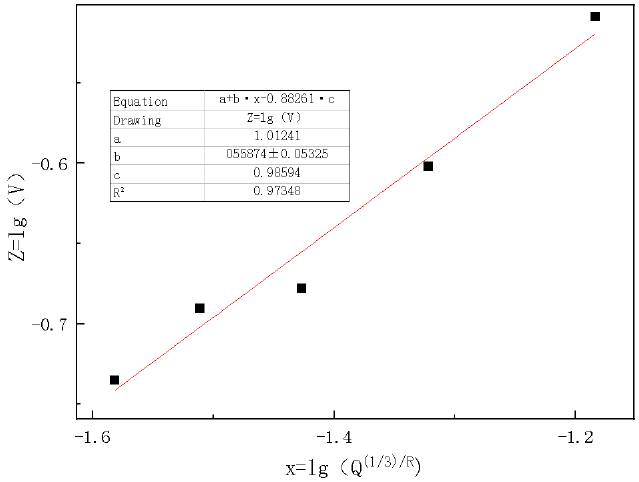
Figure 3. Regression analysis of horizontal radial vibration velocity when the elevation H = 20 m.